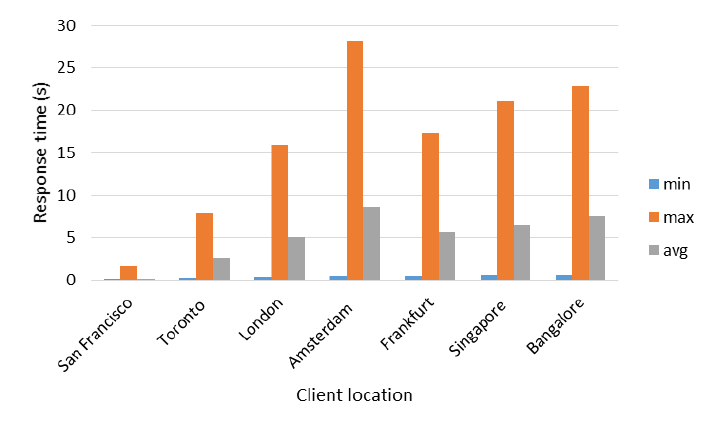
Figure 9. Minimum and maximum response times according to client location.